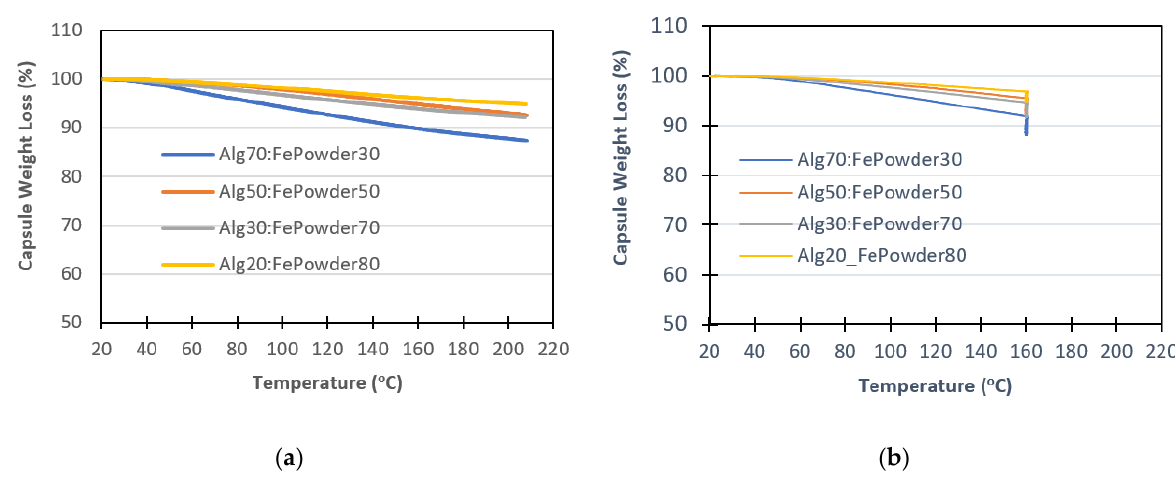
Figure 15. Conductive alginate capsule encapsulating rejuvenator oil thermogravimetric analysis (TGA) test results, ( a ) ramp temperature load, ( b ) ramp temperature load, up to 160 ° C and held for 1 h.